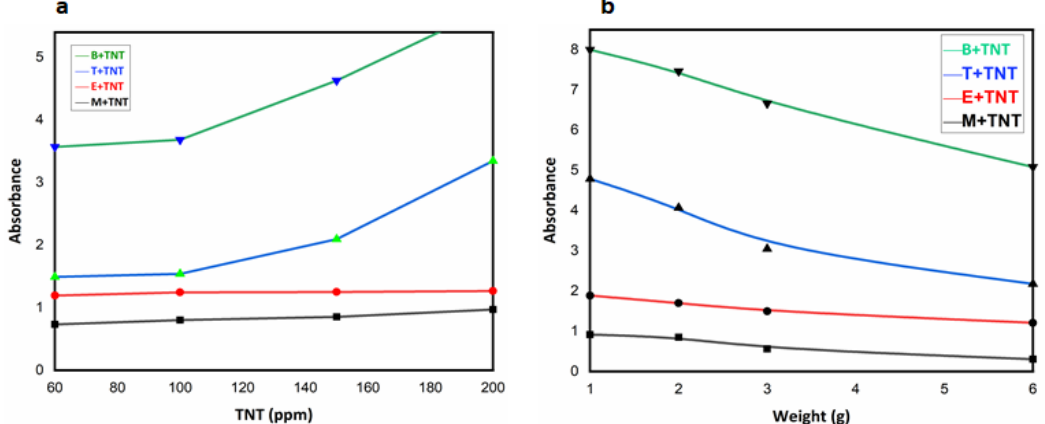
Figure 7 . ( a ) Effect of increasing TNT concentration on absorbance ( b ) Effect of increasing catalyst (Fe 3 O 4 NHS) dosage on absorbance at room temperature